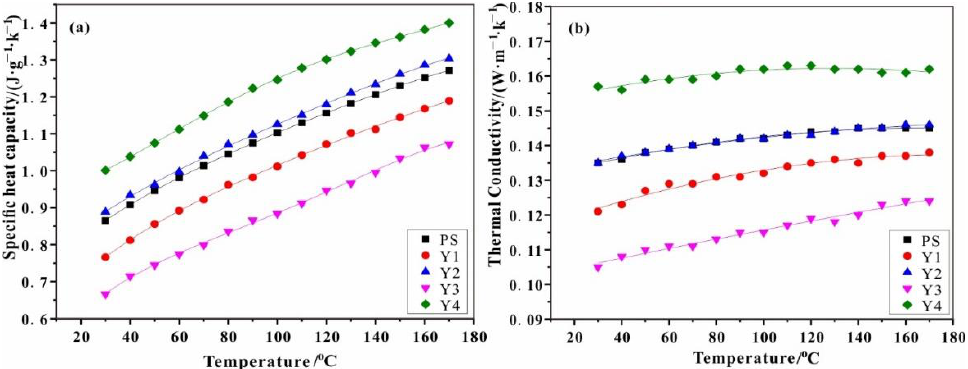
Figure 2. Physical similarity reference test experimental system diagram.